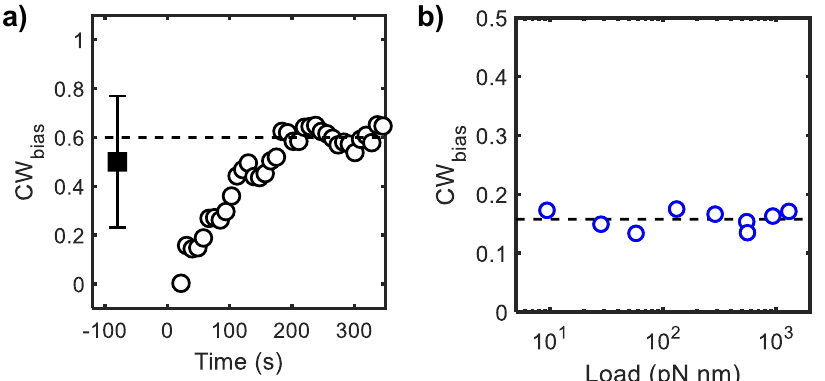
Fig. 4 Precise adaptation to mechanical stimuli. a The CW bias at low viscous load was measured to be 0.5 ± 0.27 (mean ± SD, solid square, n = 41 independent motors) in a Δ cheRcheB strain by monitoring the rotation of 300 nm beads. The standard deviation is indicated. The post-stimulus data (open circles, n = 9 independent motors) from ref. 4 shows the adaptation in CW bias when the load is suddenly increased by tethering a cell (at t = 0 s). b The steady-state CW bias for wild-type cells (open circles), calculated from the transition rates between CW-CCW directions of rotation 26,27 , is indicated as a function of load. Dotted line is a guide to the eye. Source data are provided as a Source Data fi